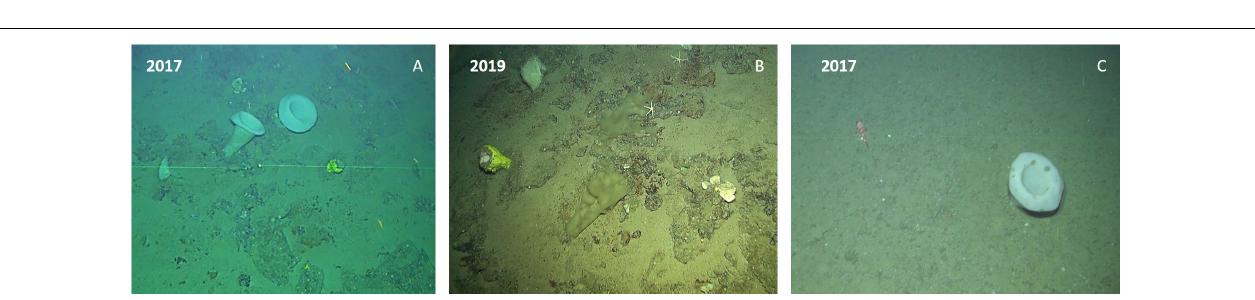
FIGURE 11 | (A,B) K (curvature parameter) is obtained from the slope of the line equation that adjusts the relationship between size parameter increment (diameter and height) and time, and determines how fast specimens grow. (C) Growth model curve for A. setubalense according to von Bertanaffy function.